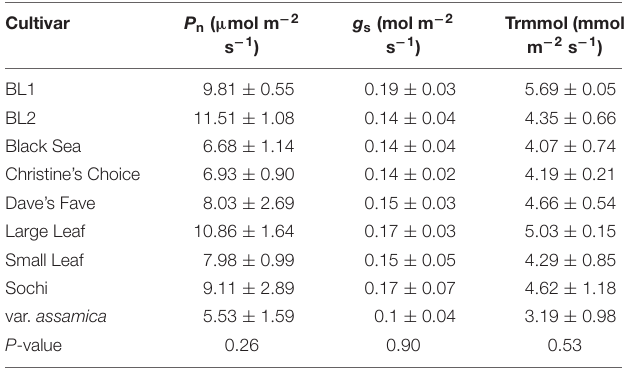
TABLE 4 | Net photosynthetic rate, stomatal conductance, and leaf transpiration rate of nine tea cultivar grown in Mississippi, United States.